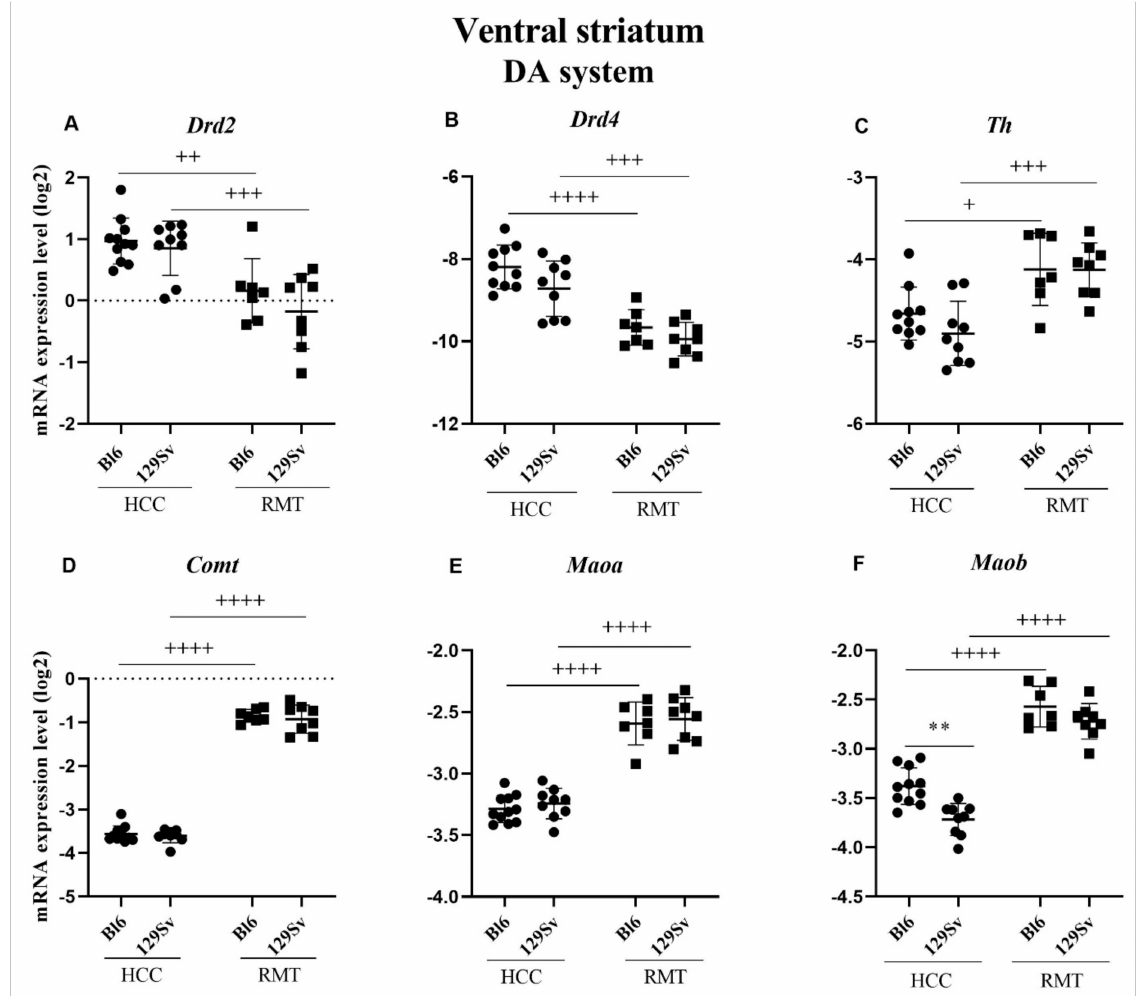
Figure 8. DA system gene expression in ventral striatum of Bl6 and 129Sv mice. Two-way ANOVA was applied to demonstrate differences between the strains and environments. Substantial statistically significant gene expressions for ( A ) Drd2 —dopamine receptor D2, ( B ) Drd4 —dopamine receptor D4, ( C ) Th —tyrosine hydroxylase, ( D ) Comt —catechol-O- methyltransferase, ( E ) Maoa —monoamine oxidase A and ( F ) Maob —monoamine oxidase B. Bonferroni post hoc test: ** p ≤ 0.01 compared to respective 129Sv mice, + p ≤ 0.05, ++ p ≤ 0.01, +++ p ≤ 0.001 and ++++ p ≤ 0.0001 in strain specific comparison. Data are expressed as mean values ± SD. Number of animals in each group varied from 7 to